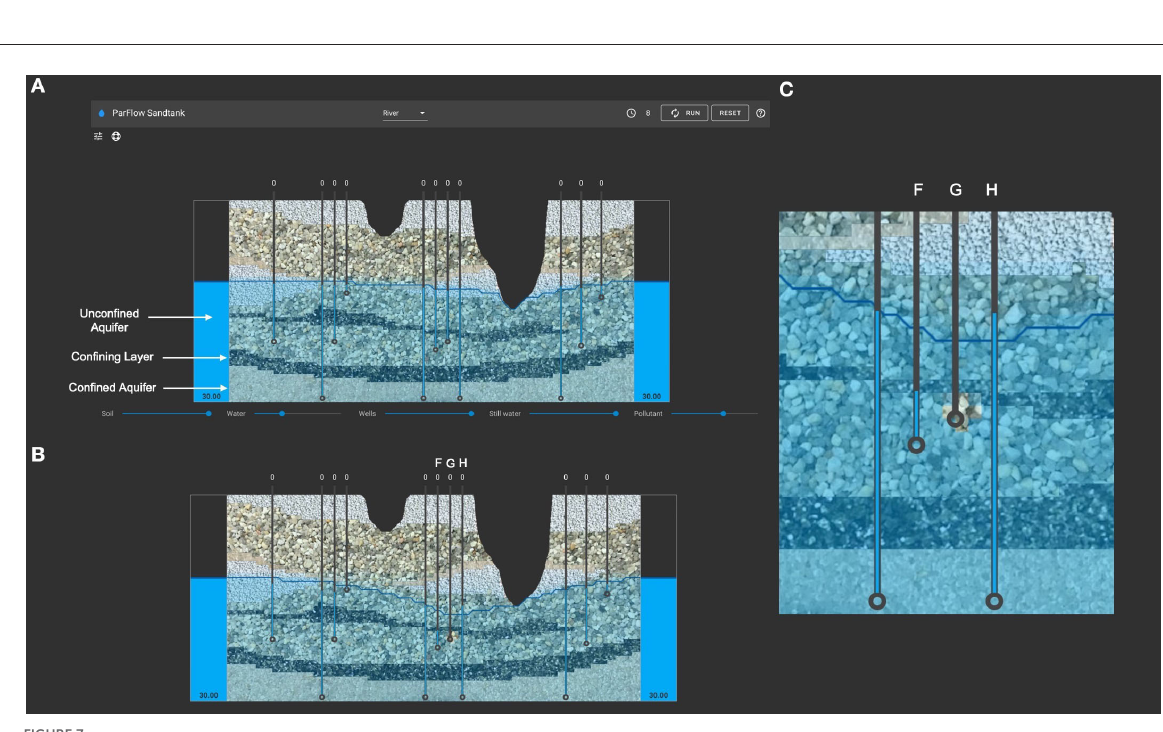
FIGURE7 Mx. Garcia’s initial ParFlow Sandtank setup and subsequent runs. (A) Initial setup of PFST showing a confined and unconfined aquifer. (B) Water levels in wells F, G, and H after students pump 5 units of water from the system. (C) Close up of water levels in wells F, G, and H after students pump 5 units of water from the